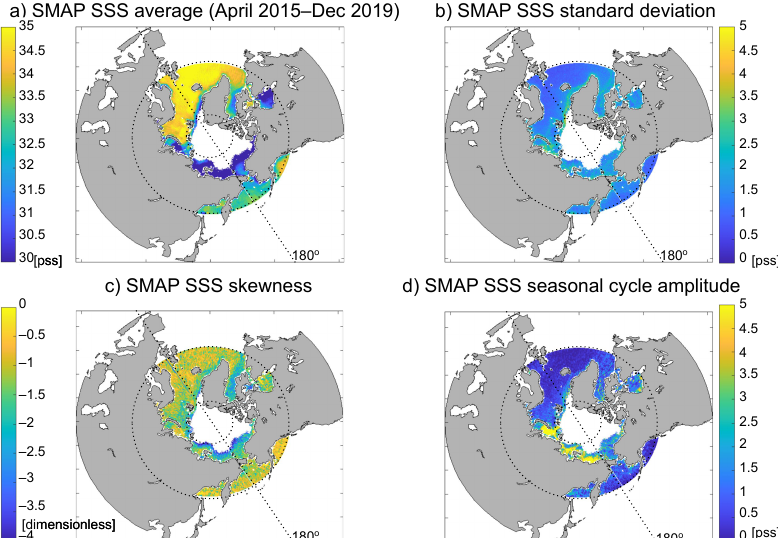
Figure 6. Statistics for SMAP Level-2 sea-surface salinity (SSS) product, corrected for the skin effect and bias (April 2015 to December 2019 due to the time range of the available OAFlux data): ( a ) SSS average, ( b ) SSS standard deviation, ( c ) SSS skewness, and ( d ) SSS seasonal cycle amplitude. The standard deviation and skewness are computed after the removal of the seasonal cycle and trend. The product synthesizes the products without interpolation, but averages all data over each nearest 50 km by 50 km grid point and over each 8-day time period, the same as for the statistics shown in Figure 3. Overlaid on top are geographical coordinates indicating where the 0 ◦ and 180 ◦ meridians, as well as the 55 ◦ N and 80 ◦ N latitudes